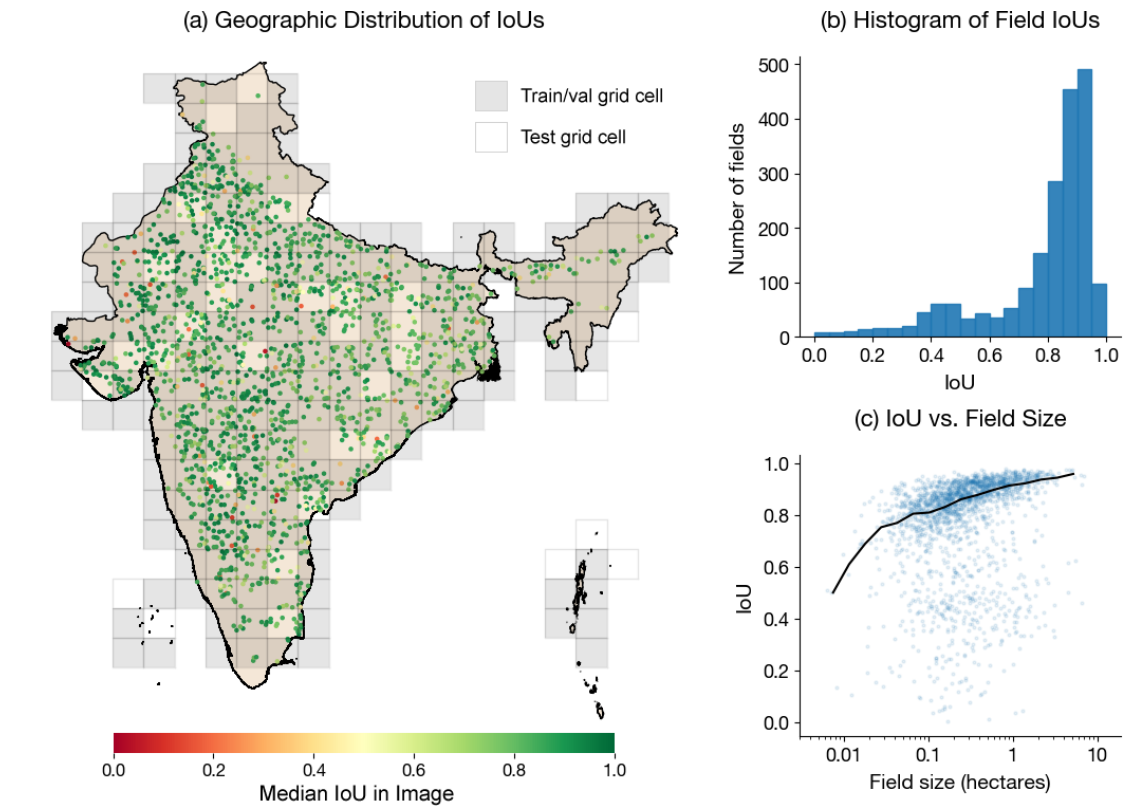
Figure 8. Airbus SPOT model’s prediction performance across India. We visualize India-wide results for the model pre-trained in France and fine-tuned on Airbus imagery in India. ( a ) Mean IoU is plotted for each test set image over a map of India. Training and validation set grid cells are grayed out, while test set grid cells are not. ( b ) A histogram of field-level IoUs in the test set. ( c ) IoU and field size have a positive correlation. The black line shows the median IoU at a field